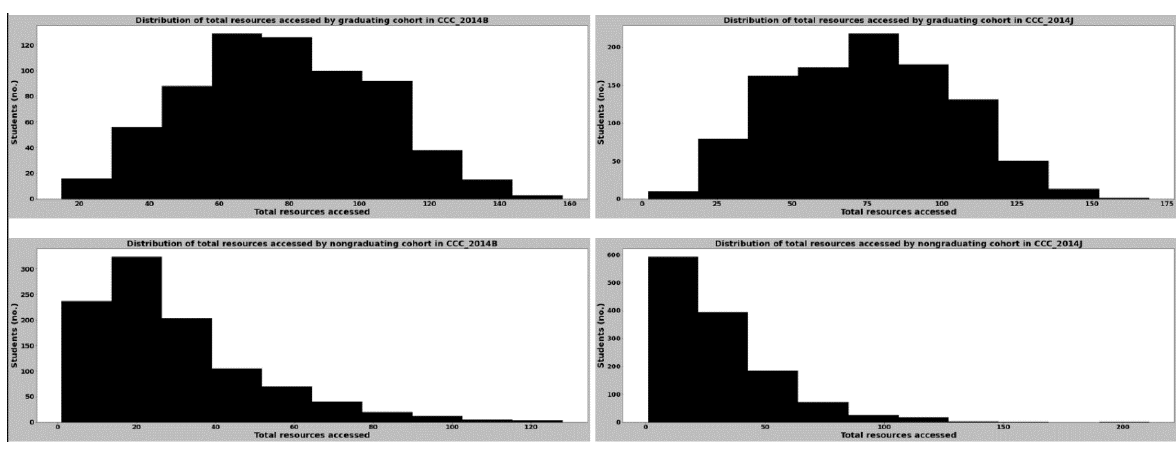
Distribution of the Total Number of Virtual Resources Accessed for Graduating and Nongraduating